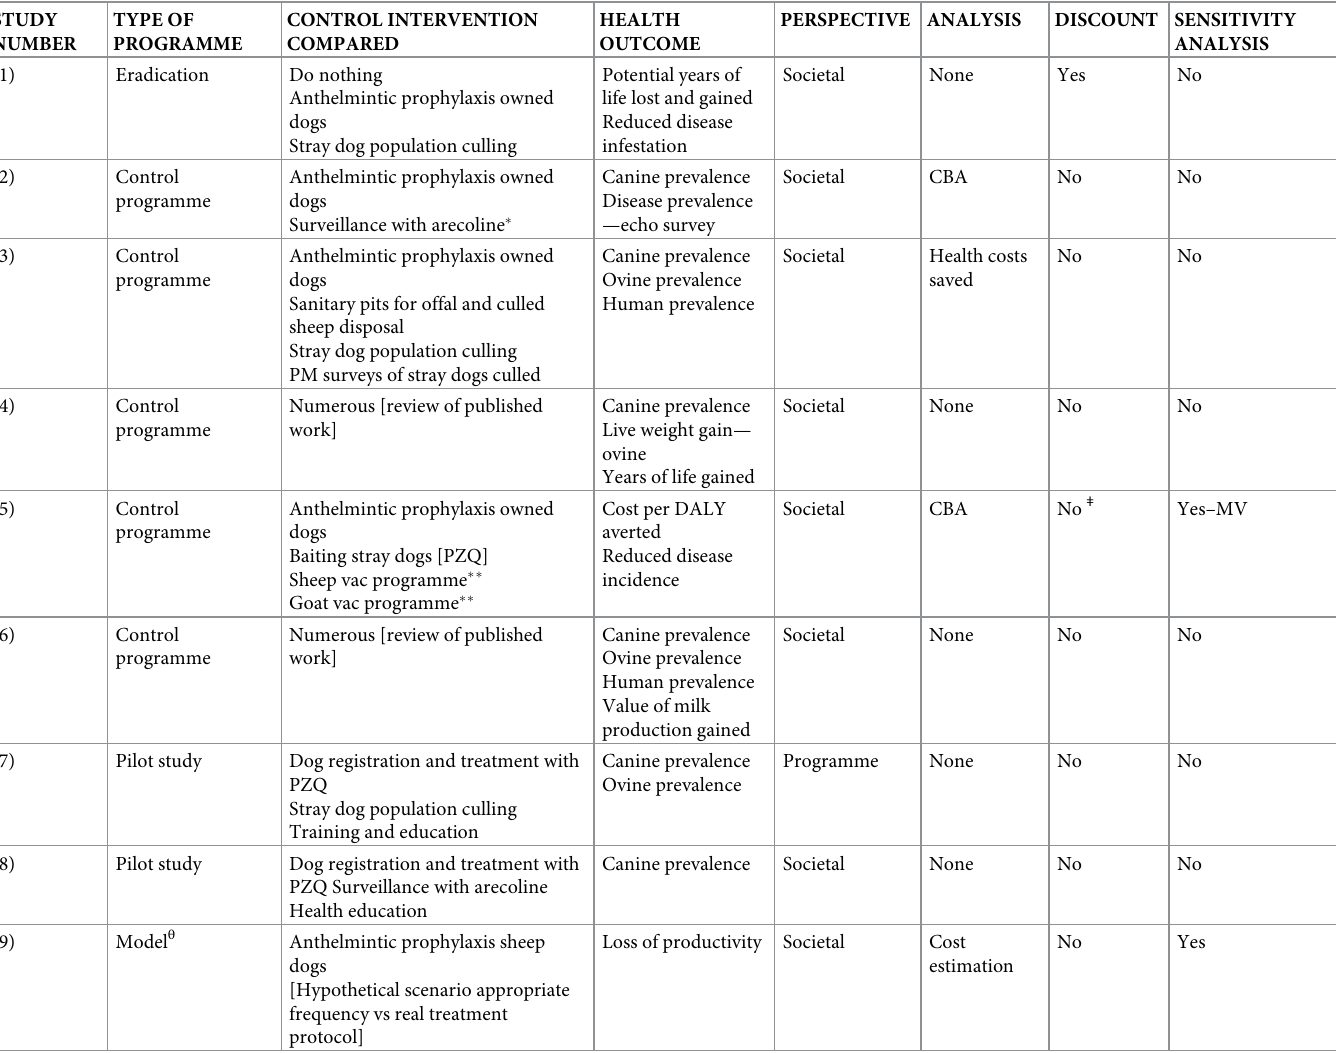
Table 2. Summary characteristics of control interventions and health outcomes for the control of Cystic